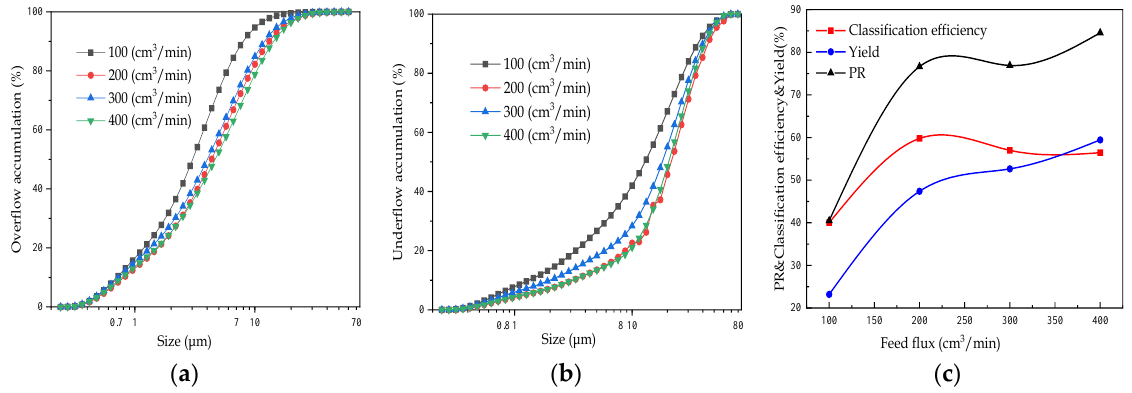
Figure 7. ( a ) Overflow particle size; ( b ) underflow particle size; ( c ) classification index. Experiment on the effect of feed flux condition.